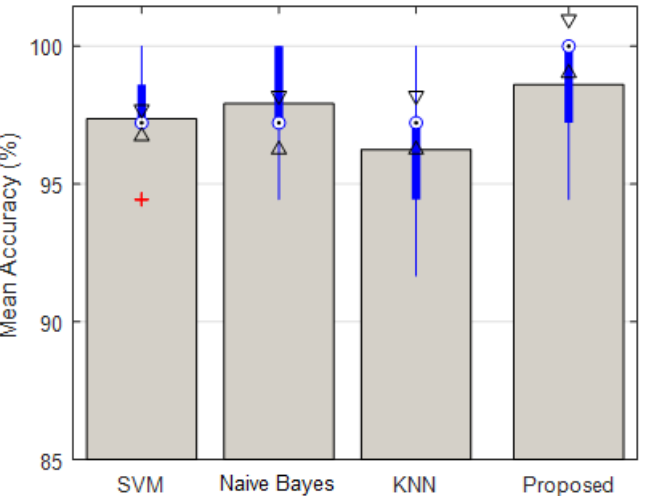
Figure 8. Average and boxplot of accuracy for different algorithms during 20 repetitions of experiments.